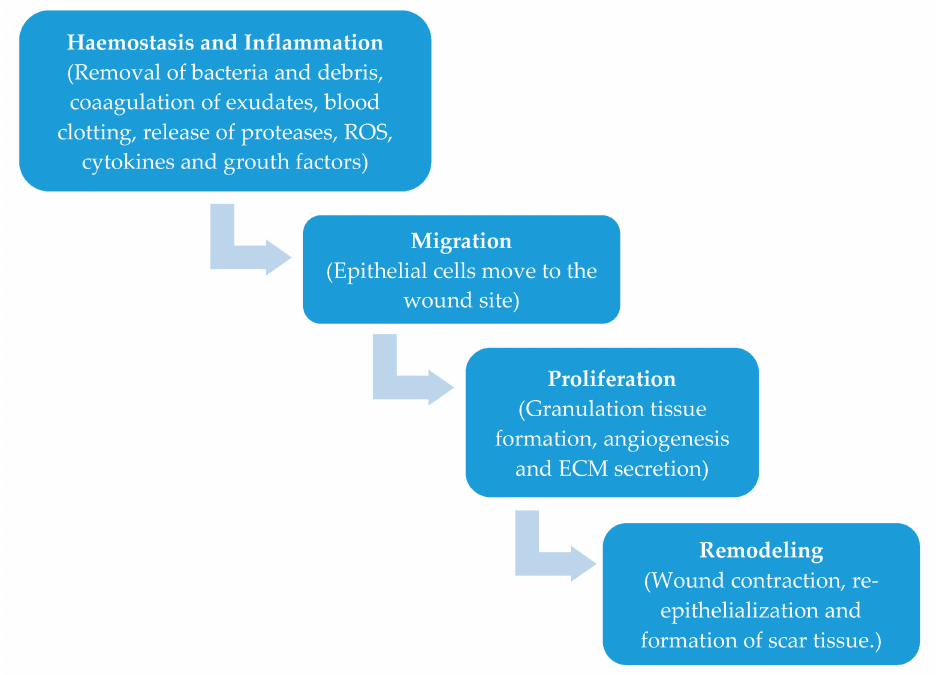
Figure 1. Phases of wound healing [2]. Reprinted from an open-access